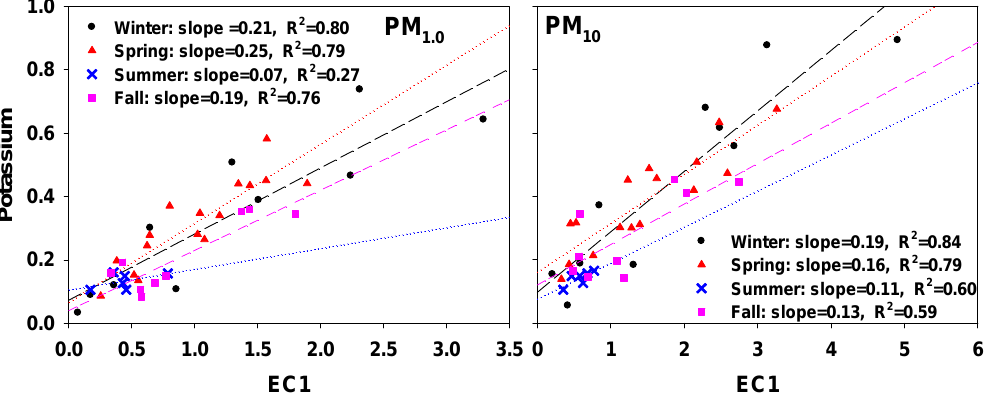
Fig. 8. Correlations of EC1 with potassium for PM 1 . 0 and PM 10 in each season. Lines stand for linear regression fittings, for which slopes and R 2 values are